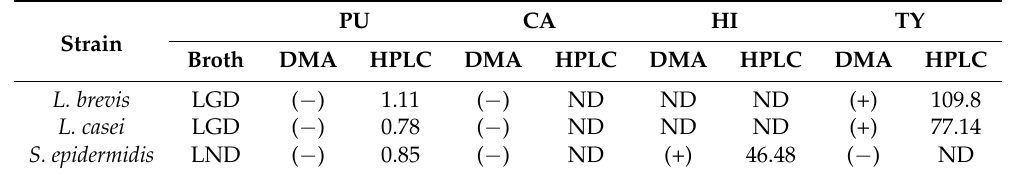
Table 3. Biogenic amine production by positive control bacteria strains in the amino acid decarboxylase microplate assay (DMA) and HPLC analysis